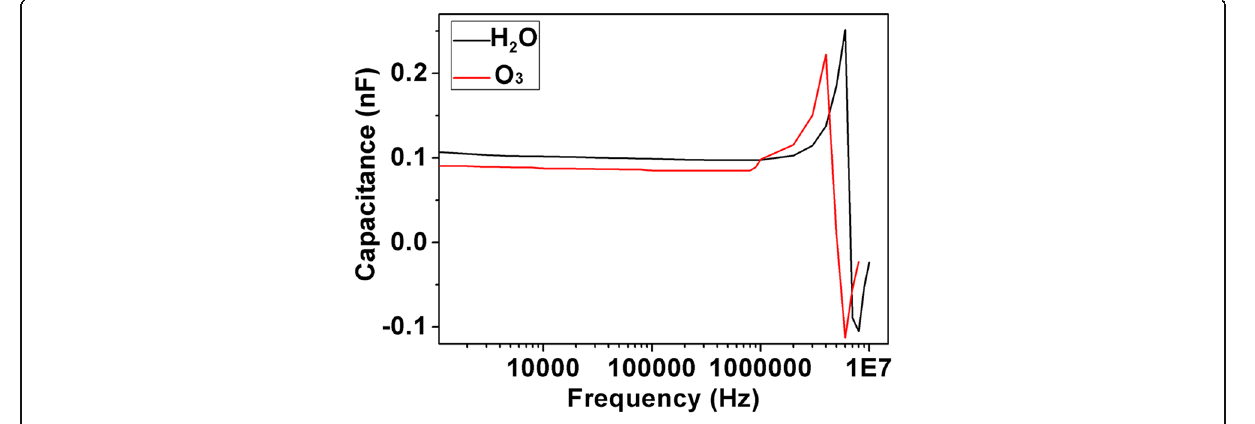
Fig. 6 C-F plot of as-deposited films with H 2 O or O 3 as the oxidizer